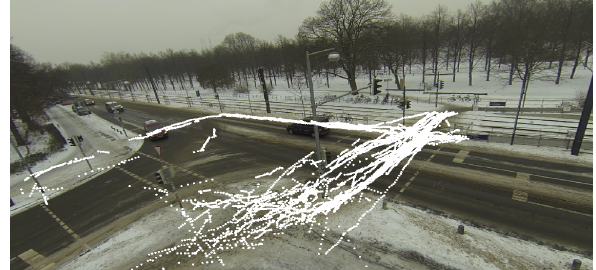
Figure 2: Snapshot of trajectories within the observed scene the manual analysis we tracked both the times a subway train stopped and the time at which traffic lights switched. In addi-